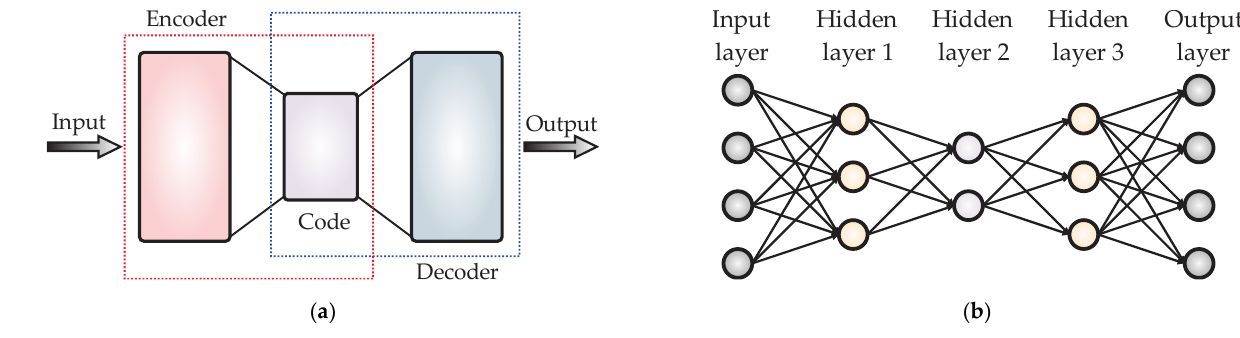
Figure 1. Typical structures of the ( a ) AE and ( b ) SAE.